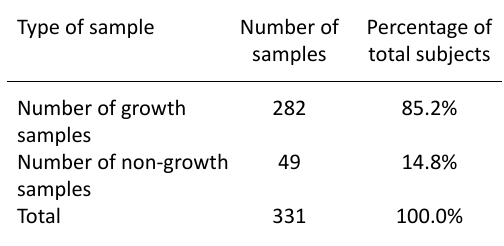
Table 3-c. Growth statistics – Number of growth and Table 3-D. Growth statistics – Number of growth